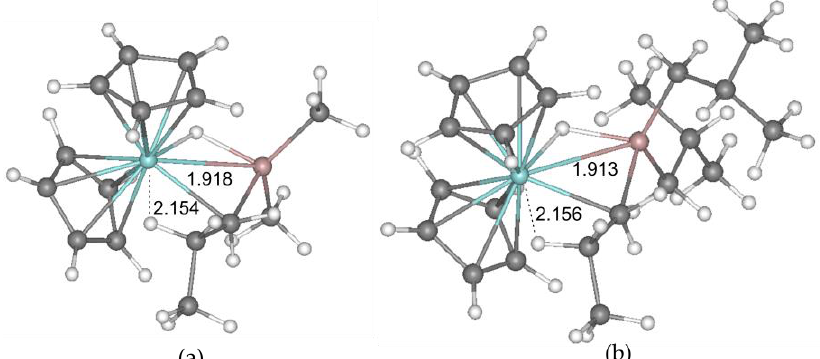
Figure 1. Calculated geometries of I-2H-bo complexes for ( a ) R = Me and ( b ) R = i Bu. The distances Zr-H are specified